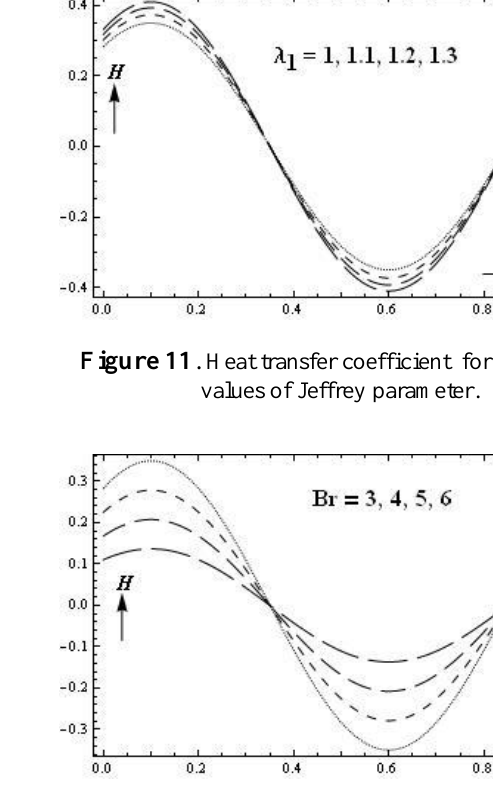
Figure 13. Heat transfer coefficient for various values of Brinkman